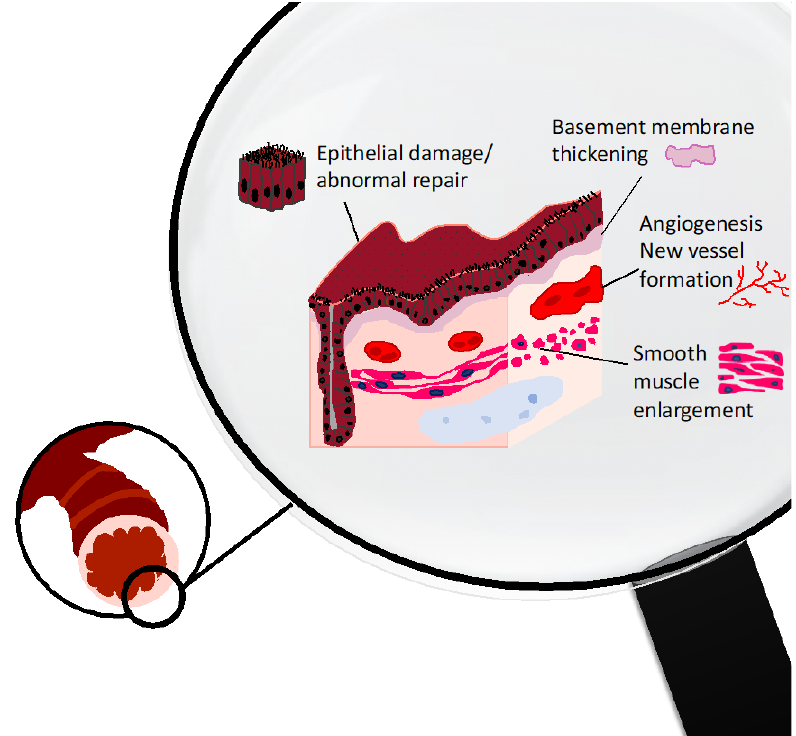
Figure 1. The main pathological hallmarks of remodeling in asthma encompass alterations in different airway compartments: airway epithelium (epithelial shedding, mucous cell metaplasia); subepithelial basement membrane (collagen deposition and thickening of the reticular layer); blood vessels (neoangiogenesis); and airway smooth muscle (enlargement due to hypertrophy/hyperplasia).